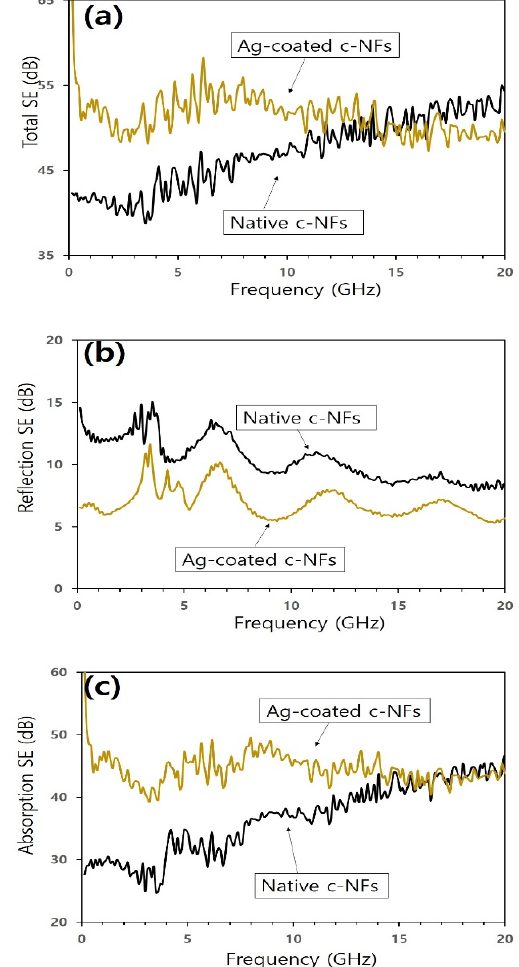
Figure 8. ( a ) Total SE spectra; ( b ) components of SE spectra owing to reflection; and ( c ) components of SE spectra owing to absorption for both native and Ag-coated c-NFs samples. SE spectra owing to absorption for both native and Ag-coated c-NFs